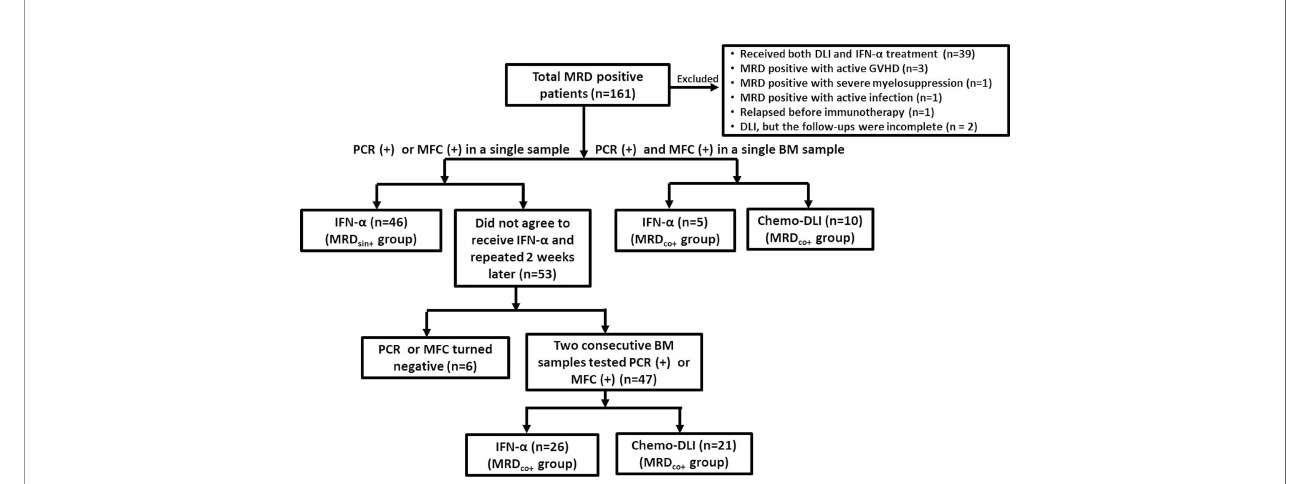
FIGURE 1 | Diagram of enrolled patients. Among the 53 patients with MRD sin+ who did not agree to receive any interventions, 22 of them reduced immunosuppression after the MRD sin+ diagnosis, but only 2 of them showed MRD clearings when the tests were repeated 2 weeks after the fi rst positive results were obtained. Four patients showed MRD negative without any interventions. (MRD sin+ group, n=46; MRD co+ group: IFN- a n = 31, Chemo-DLI n =